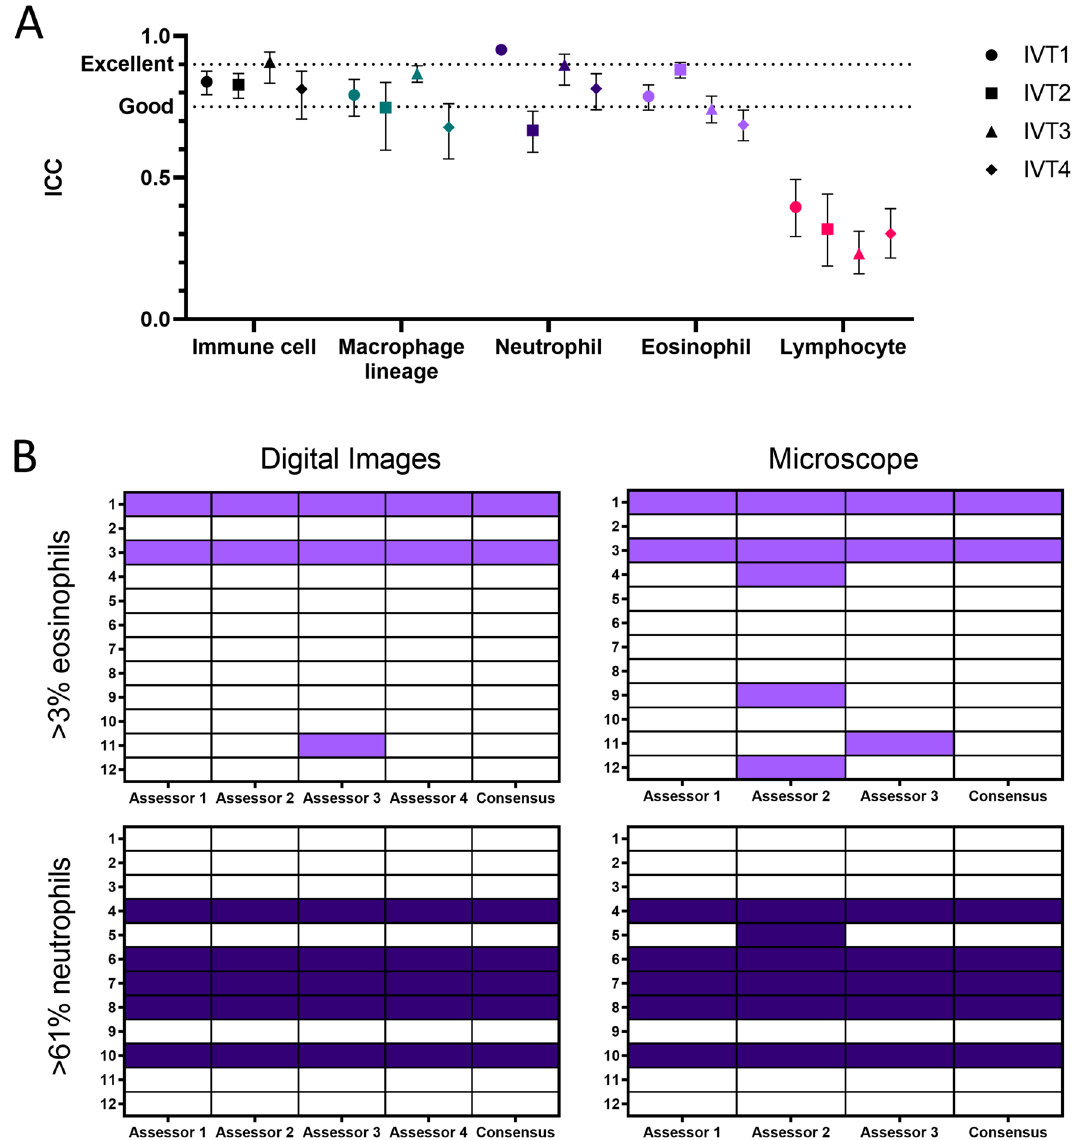
Figure 3. Assessor agreement at both object level and final cytospin determination. ( A ) Good agreement between the four assessors was achieved in all outcomes except identification of lymphocytes. Data represents four separate rounds of annotation and interperson variability testing (IVT), each performed using at least 160 digital images of cytospins. The agreement between the four assessors was calculated for each immune cell class (Macrophage lineage, Neutrophil, Eosinophil, Lymphocyte) as well as agreement at a total level (“Immune Cell”) and is presented as intraclass correlation coefficient (ICC). Lines indicate cutoffs for “good” (≥ 0.75) and “excellent” (≥ 0.90) agreement 22 . ( B ) Agreement in final assessor determination of asthma cytopsins according to criteria of either > 3% eosinophils or > 61% neutrophils (rows), based upon data from the digital image annotations or counts performed through physical viewing by microscope (columns). Closed cells indicate the source cytospin was determined to positively meet criteria threshold, open cells indicate negative ferent maximal distance ( δ ) thresholds from the cell centre (10%, 25%, 50% of cell size). The AP for both DCNet and human assessors decreased as the distance to ground truth threshold was reduced (Fig. 4). However, DCNet was able to achieve human baseline performance and matched or exceeded the average human AP, either at an individual object class (Fig. 4A–D) or total immune cell count (Fig. 4E). Despite macrophages and monocytes being the predominant cell class, both the DCNet and human AP for this class were lower than expected for the number of labelled objects, even at a δ threshold of 0.5. However, DCNet (AP 60.84%) still outperformed three of the four human assessors (average AP 54.5%). For both the neutrophil and eosinophil classes, DCNet displayed a consistently excellent AP across the δ thresholds (Fig. 4B,C). The most notable limitation was the lowest AP across all distance thresholds for the lymphocyte class (Fig. 4D). However, this was a consistent issue for the humans annotators (Fig. 3A) and DCNet at least matched the average AP of our human assessors. The low AP